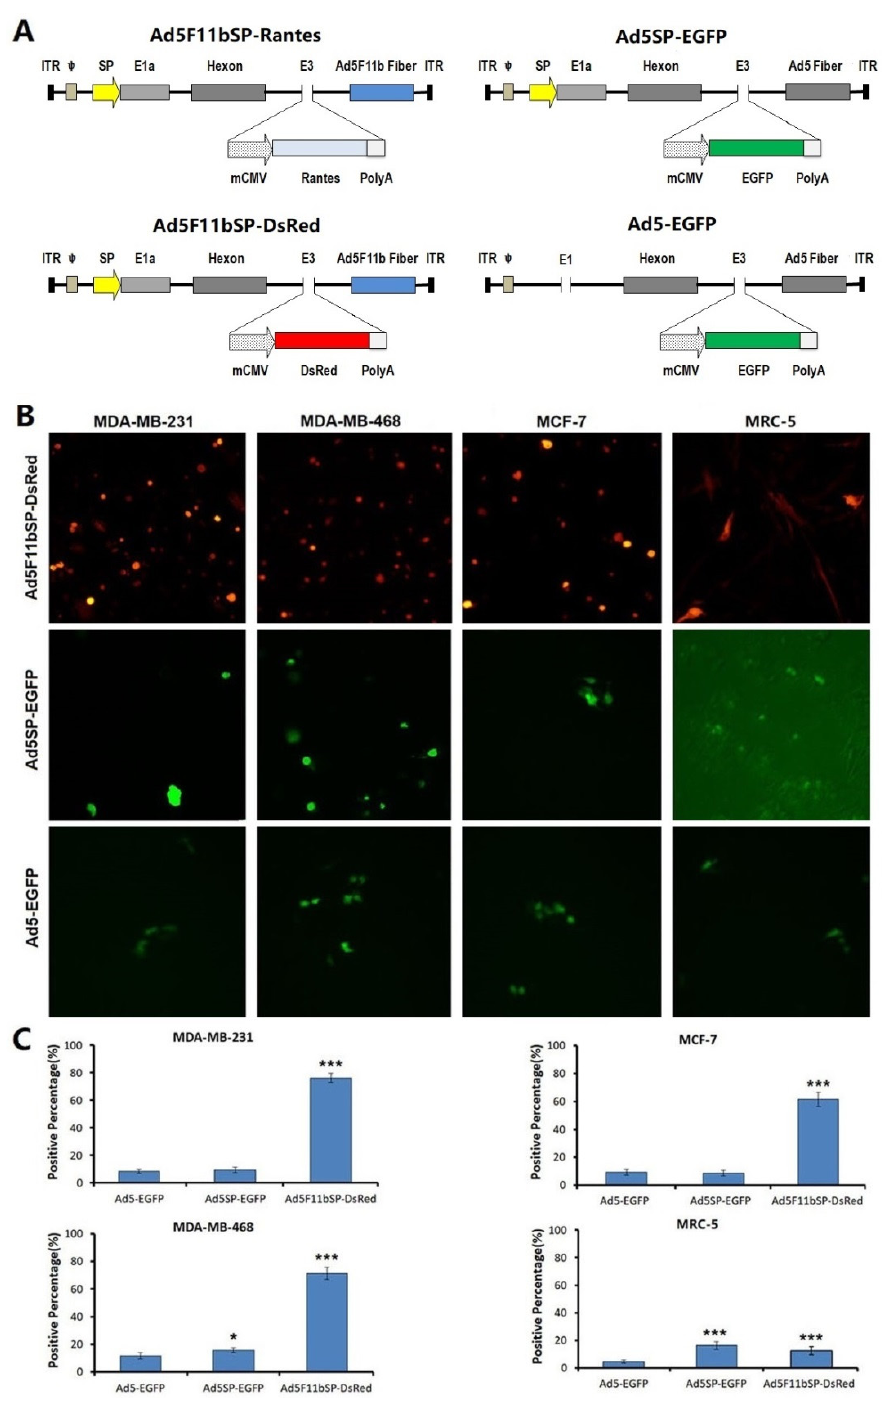
Figure 1. Construction of oncolytic adenovirus and identification of viral infection efficiency. ( A ) The survivin promoter (SP) controls E1a expression in oncolytic adenoviruses, the fiber is modified into chimeric Ad5F11b and the expression cassette of chemokine Rantes is inserted into the E3 region. ( B , C ) Identification of the infectious capability of the oncolytic virus Ad5F11bSP-DsRed, the oncolytic virus Ad5SP-EGFP without chimeric Ad11b fiber and the replication-deficient adenovirus Ad5-EGFP to breast cancer cells and normal cells. The cells were cultured in 24-well plates, 5 × 10 4 cells/well, and the multiplicity of infection (MOI) was 100 pfu/cell. The infection contact period was 60 min. After 24 h of culture, the expression of fluorescent protein reporter gene was observed under a fluorescence microscope, and the proportion of positive cells within 5 high magnification fields was counted. Compared with the virus Ad5-EGFP, * p <0.05, *** p <0.001.